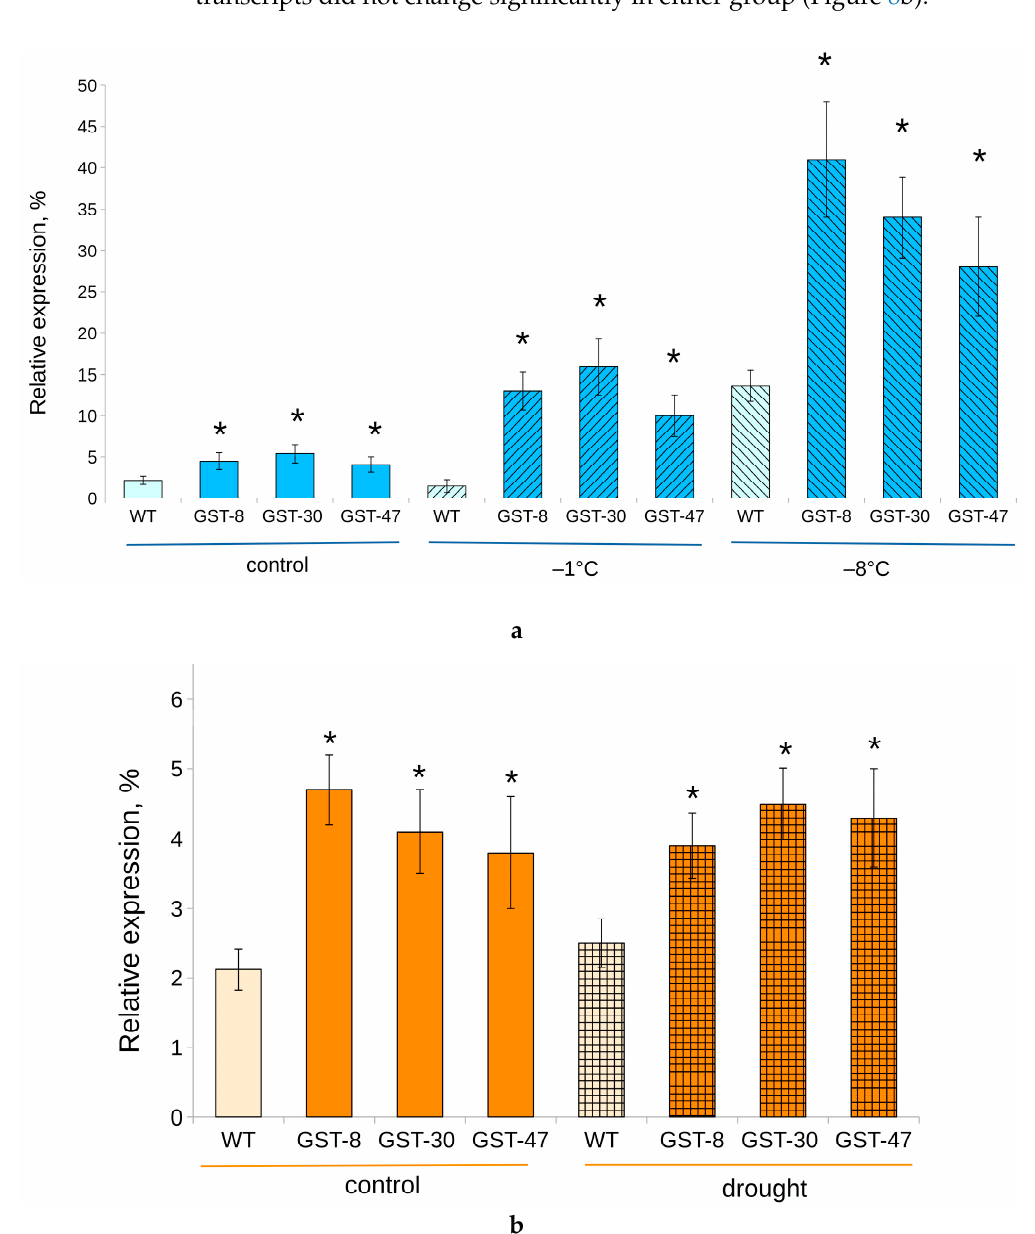
Figure 8. Relative level of expression of GSTF11 gene in transgenic (GST, lines 8, 30 and 47) and WT B. napus . ( a ) Cold stress; ( b ) Drought stress. Asterisk (*) indicates a significant difference between WT and transgenic plants from the same group.